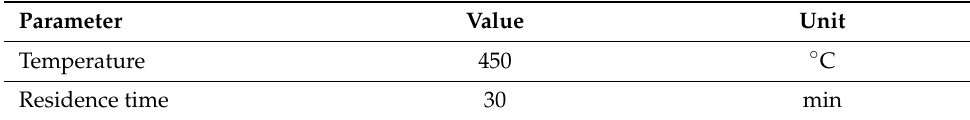
Figure 1. Simplified P&ID of the pilot scale pyrolysis reactor. Table 4. Slow pyrolysis conditions adopted for the